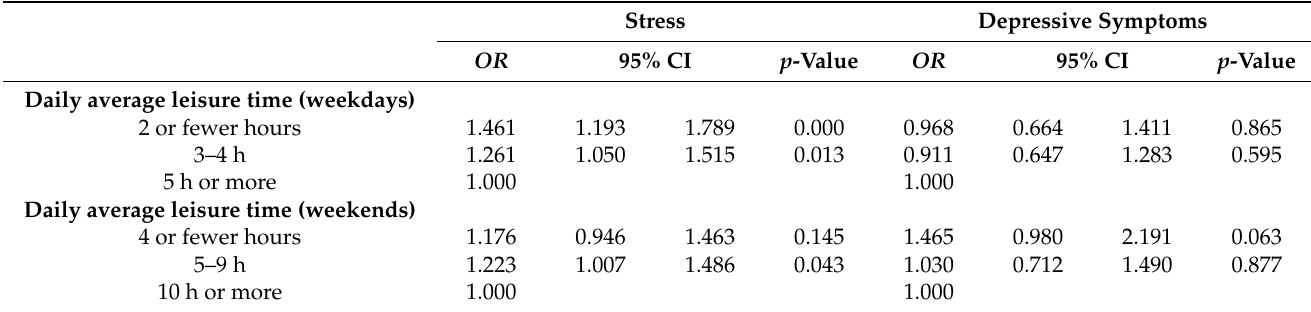
Table 2. Association between average leisure time and mental health.